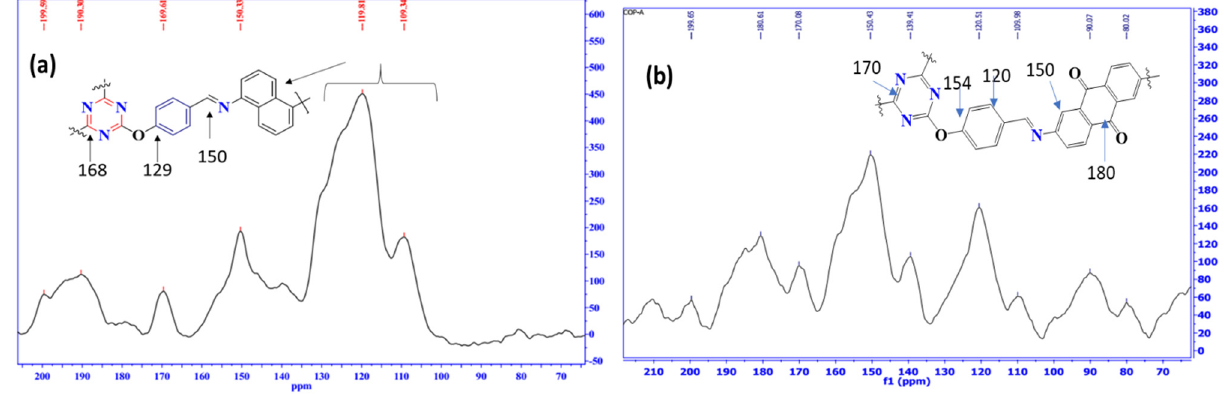
Figure 3. 13 C SSNMR spectra of triazine based polymer of the ( a ) COP-N and ( b ) COP-A.